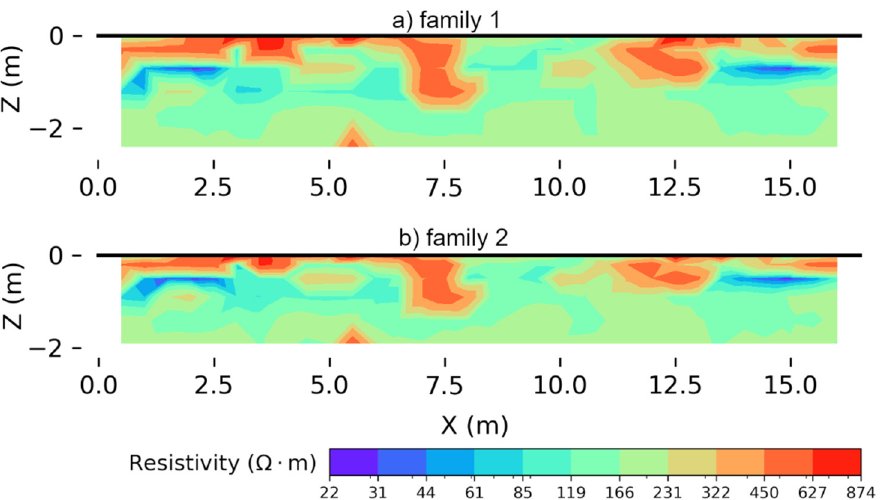
Figure 9. Example of two different clusters of equivalent models obtained by k -means clustering. ( a ) family 1 from the 1st cluster; ( b ) family 2 from another cluster of the equivalent models.